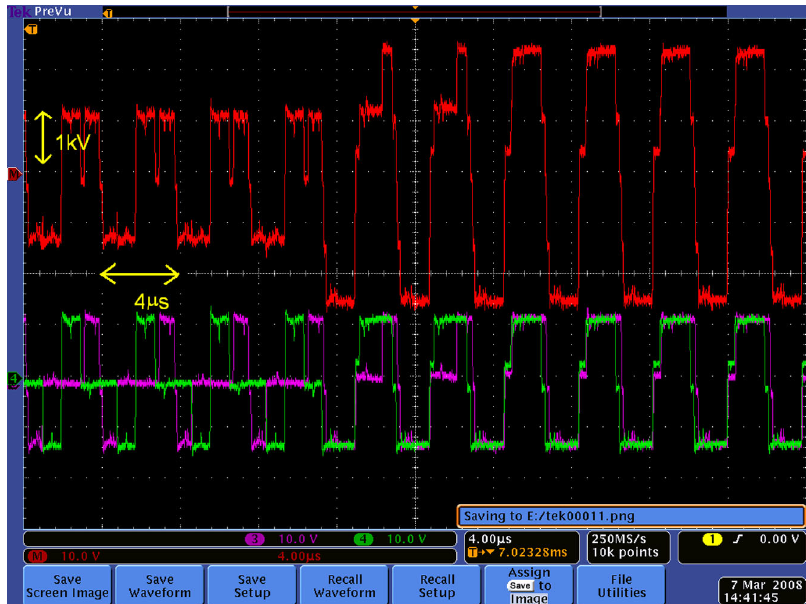
FIG. 39. Output voltage waveform at the transition between stages 1 and 2. (Voltage and time scales are indicated by double-headed